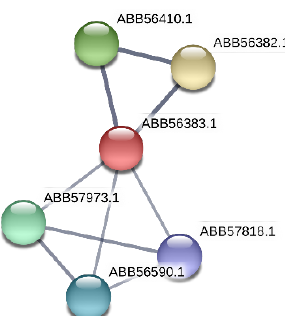
Figure 4. Network of ABB56383.1 protein ( Synpcc7942_0351 ) and its protein partners according to STRING (https://string-db.org) is shown. In this figure: ( 1 ) protein ABB56410.1 ( Synpcc7942_0378 ) is MlaE, ABC transporter phospholipid/cholesterol/gamma-HCH transport system permease protein; ( 2 ) protein ABB56382.1 ( Synpcc7942_0350 ) is MlaF, phospholipid/cholesterol/gamma-HCH transport system ATP-binding protein; ( 3 ) protein ABB57818.1 ( Synpcc7942_1 788) is translocation and assembly module TamB protein; ( 4 ) protein ABB56590.1 ( Synpcc7942_0558 ) is conserved hypothetical protein, chaperone-like protein; ( 5 ) protein ABB57973.1 ( Synpcc7942_ 1943) is cell division protein Ftn2-like.